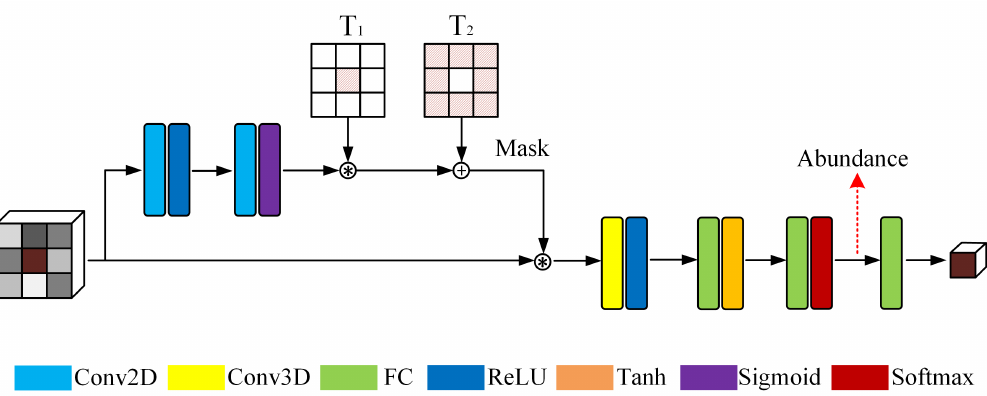
Figure 1. Architecture of gated three-dimensional convolutional autoencoder network.